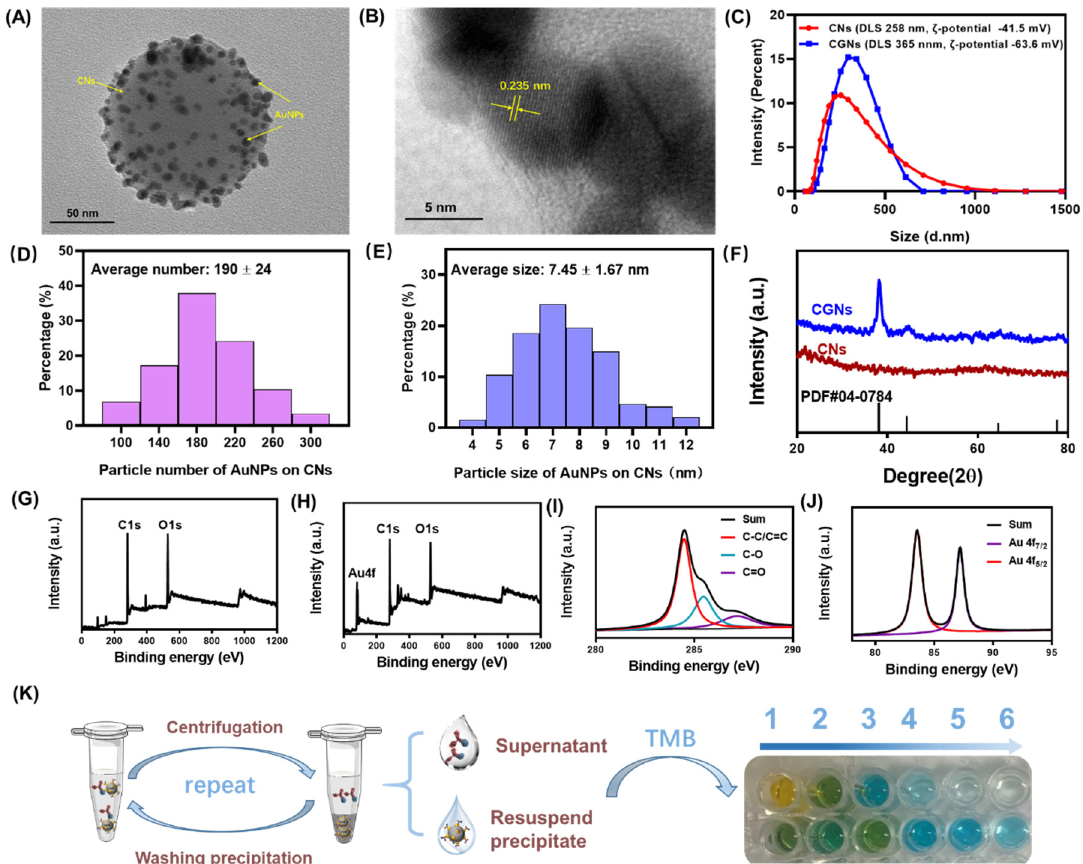
Figure 5. Characterization of CGNs. High resolution TEM images of ( A ) CGNs and ( B ) the crystalline structure of a gold nanoparticle on CNs with 0.235 nm lattice space. ( C ) Size distribution of CNs and CGNs by intensity. ( D ) Particle number distribution of AuNPs on CNs. ( E ) Particle size distribution of AuNPs on CNs. ( F ) XRD pattern of CNs and CGNs. XPS wide scan of ( G ) CNs and ( H ) CGNs. High-resolution XPS spectrum of ( I ) C1s of CNs and ( J ) Au4f of CGNs. ( K ) Chromogenic reaction of HRP and TMB for characterizing CGNs@AntiBNP-HRP. Table 1. The ratio of m AntiBNP-HRP to m CGNs in the CGNs@AntiBNP-HRP immunoprobe. Mass